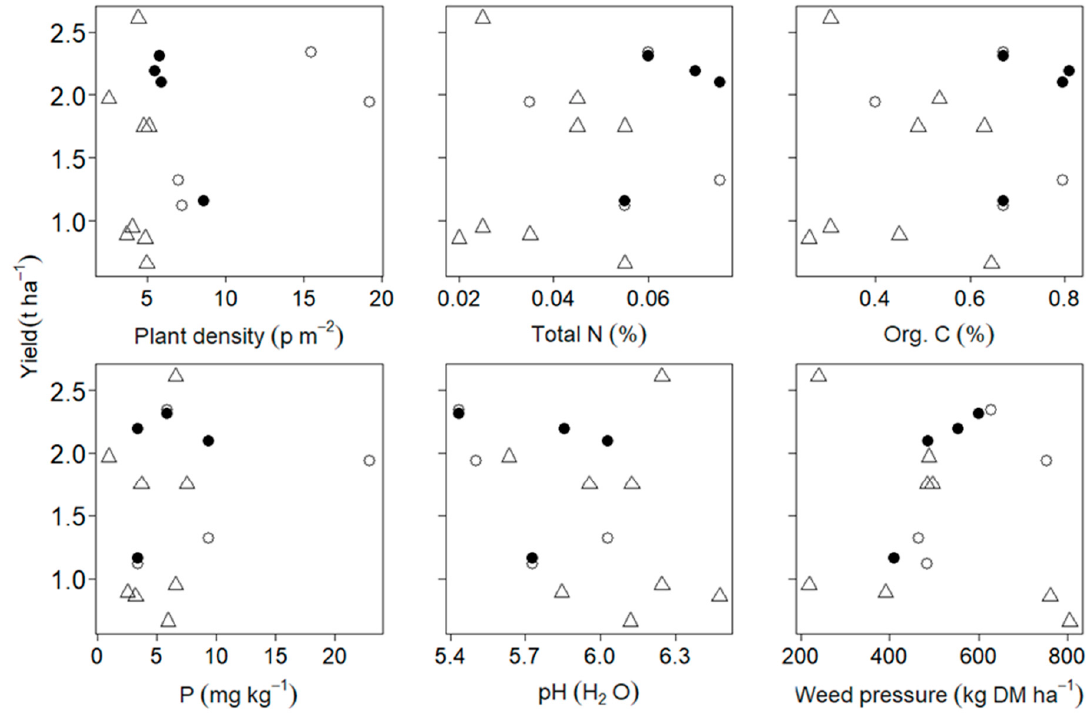
Figure 3. Grain yield (15% moisture content) of maize (t ha − 1 ) against soil nutrient, agronomic practices (plant density and weed pressure) for Amantin-Atebubu major season (AAMajor) ( ○ ), Amantin-Atebubu minor season (AAMinor) ( ● ) and WM ( △ ).